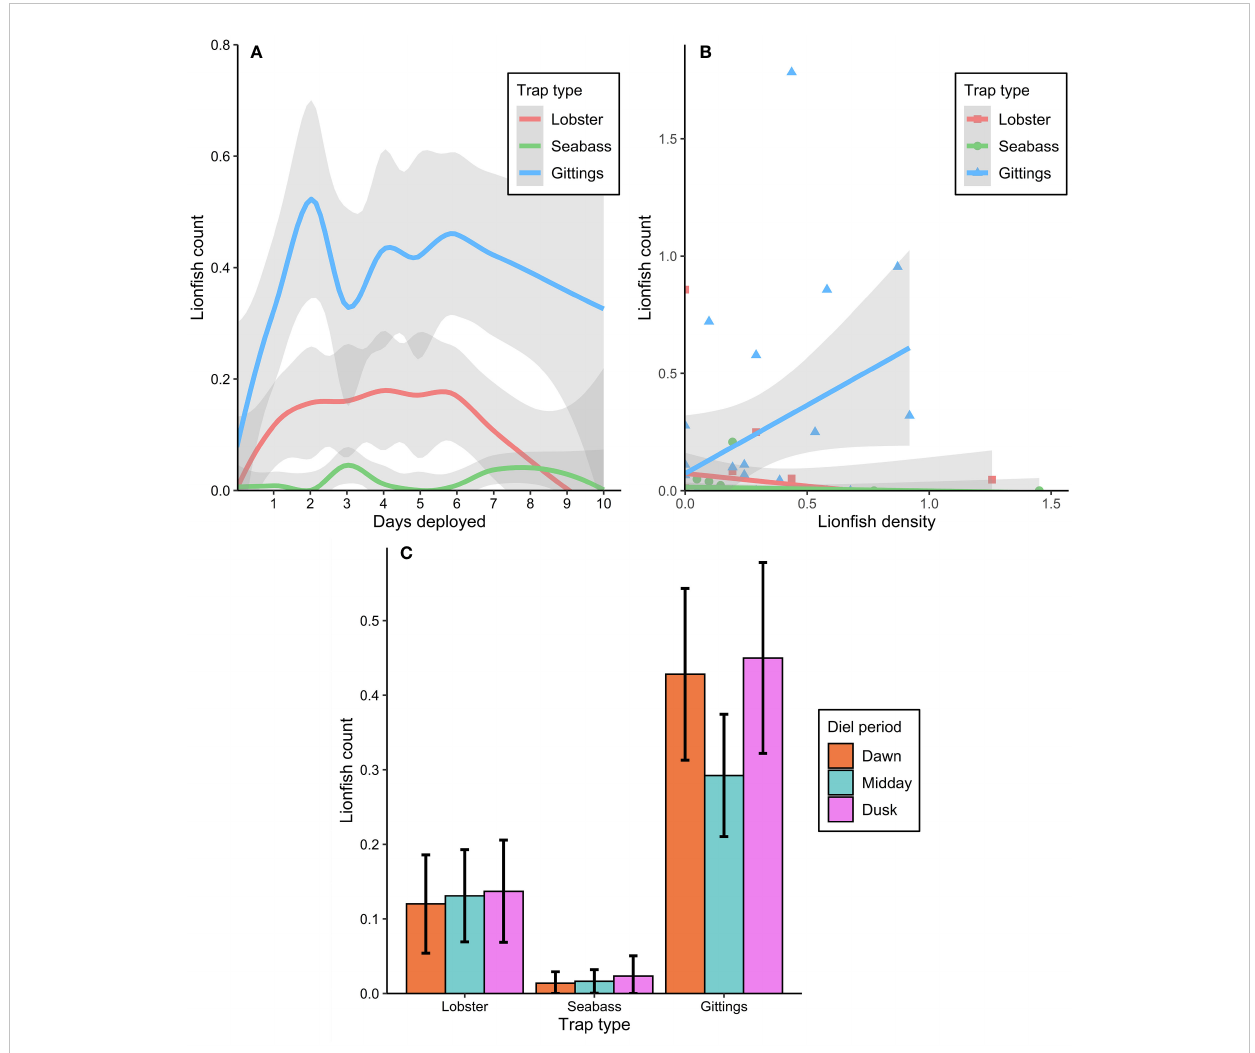
FIGURE 8 Effects of trap type, soak time, lion fi sh density, and diel period on lion fi sh recruitment to traps (i.e., number of lion fi sh inside the footprint of the Gittings trap or inside the container of the lobster and sea bass traps) as measured by remote time-lapse video cameras. (A) Non-parametric locally estimated scatterplot smoothing curves (± 95% CI) for mean lion fi sh recruitment plotted against soak time and by trap type. (B) Mean (± 95% CI) lion fi sh recruitment plotted against a site ’ s lion fi sh density as estimated by remotely operated vehicle surveys, with regression lines for each trap type. (C) Bar plot of mean (± 95% CI) lion fi sh recruitment by trap type during dawn (within 2 h of sunrise), midday (noon), or dusk (within 2 h of sunset) diel